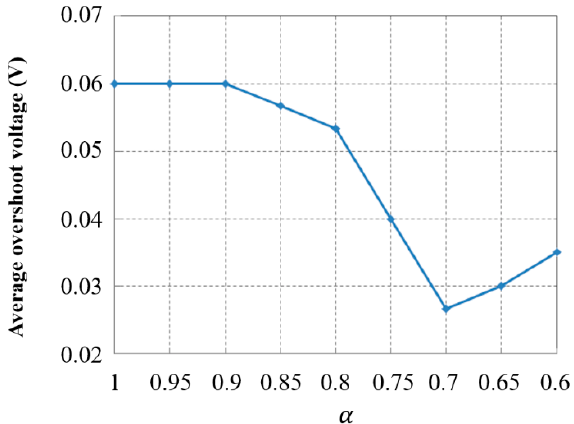
Figure 5. Simulated average overshoot voltage waveform in terms of α of the proposed EDRC scheme, in the case where increasing V g changes the operation mode of output 2. The simulation environment is as follows: V g = 2 V, V O1 = 1.5 V, V O2 = 2.5 V, and V O3 = 3.3 V.